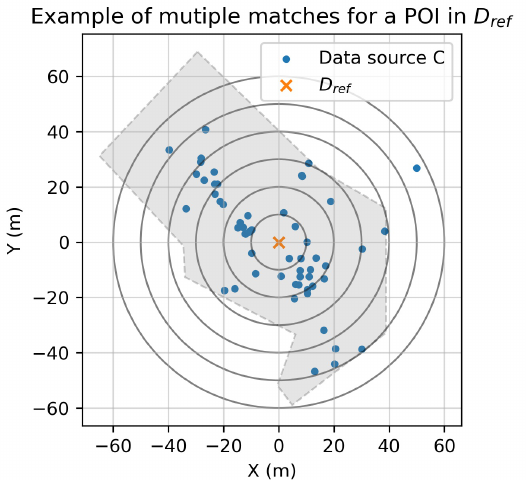
Figure 9. An example where multiple POIs from data source C are matched to a single POI in D ref . Building outline is shown in